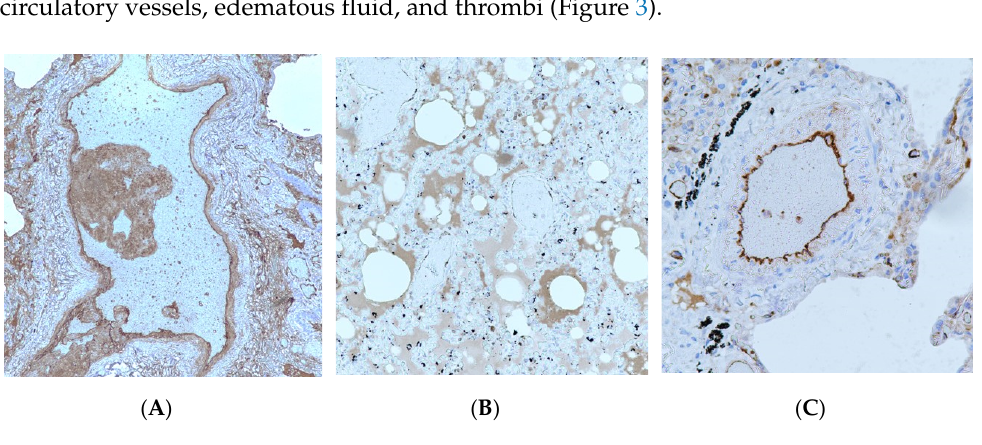
Table 2. Comparative intergroup analysis of mean optical density in pulmonary vascular endothe- lium in groups of patients with duration of disease more/less than 10 days.